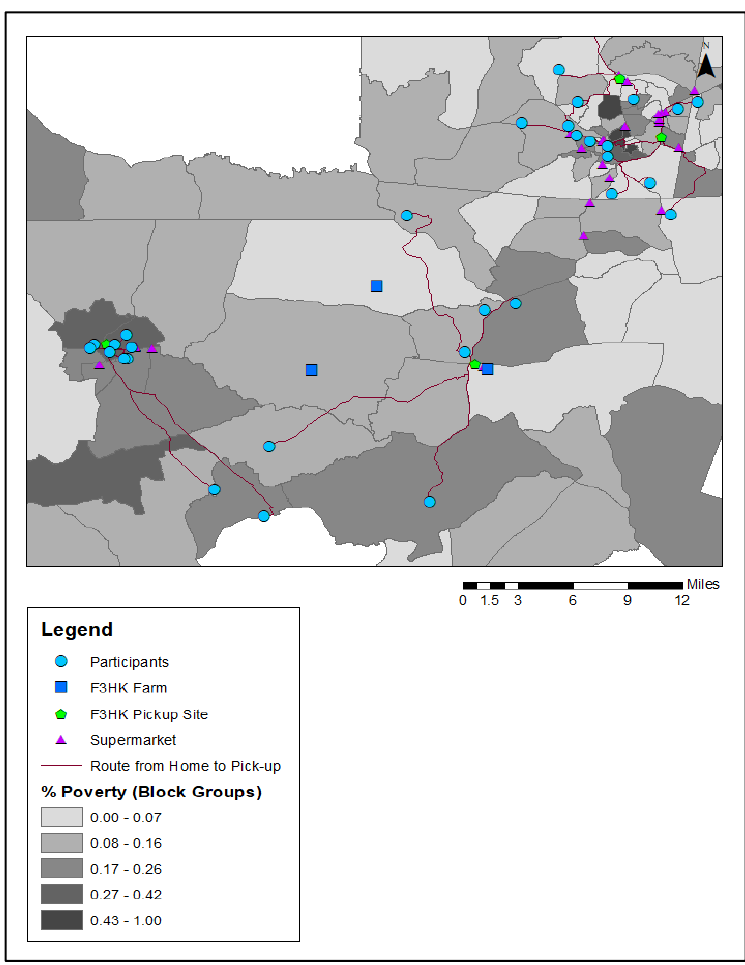
Figure 3. Map of GIS Analysis for Geospatial Characteristics of the Environmental and Sociodemographic Context of Farms, Pickup Locations, and Participant Residential Locations